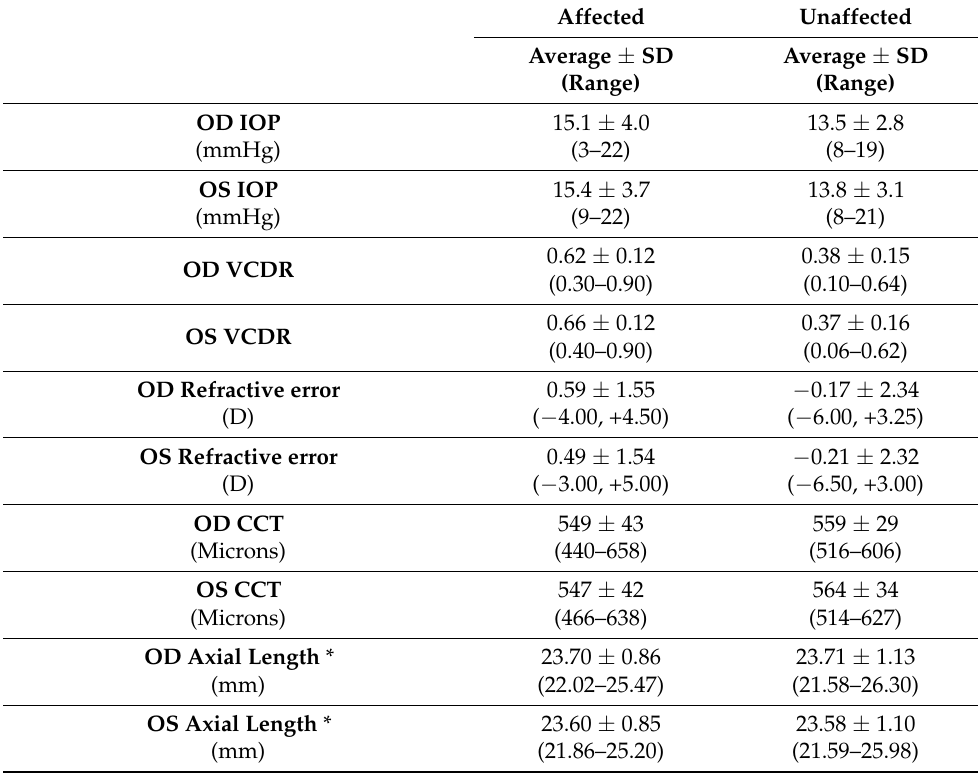
Table 3. Quantitative eye measurements. Measurements were obtained from eye exams performed at the Ohio Eye Associates office. These data were obtained for 42 glaucoma-affected study participants and 20 unaffected individuals. IOP: intraocular pressure. VCDR: vertical cup-to-disc ratio. OD: oculus dexter (right eye). OS: oculus sinister (left eye). Refractive error: Spherical equivalent from distance refraction. D: